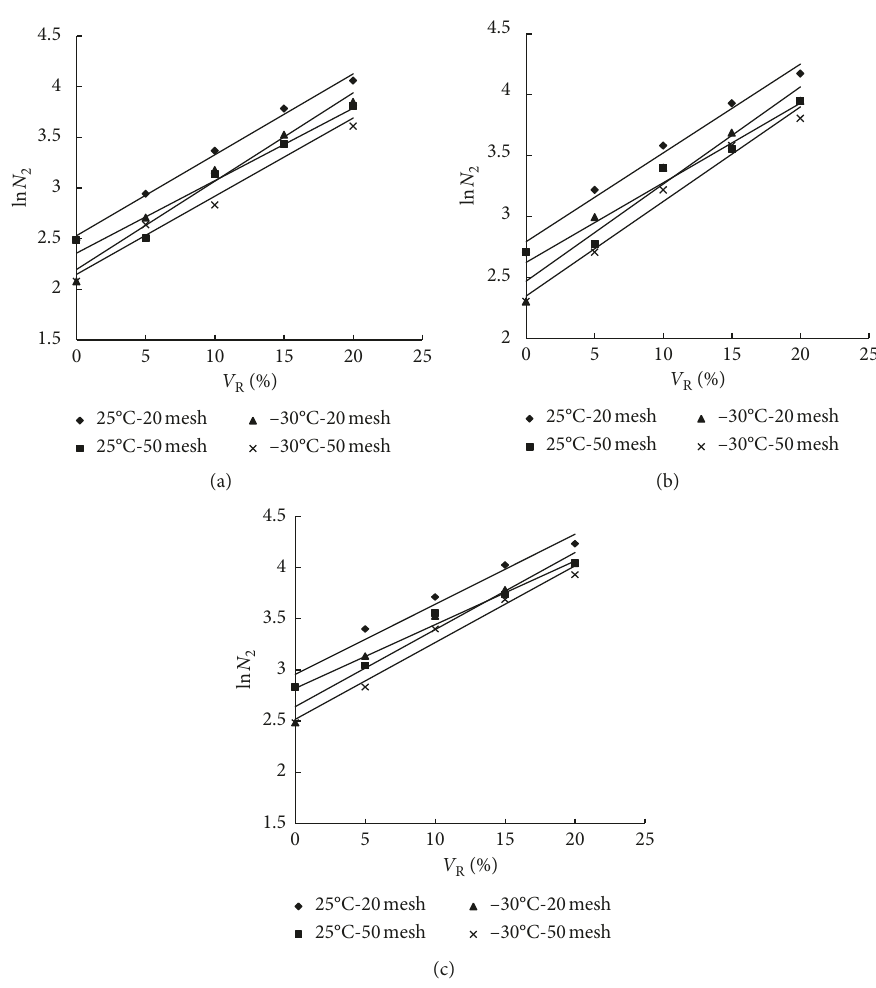
and V . Failure probability is (a) 10%, (b) 20%, and (c) 2 R